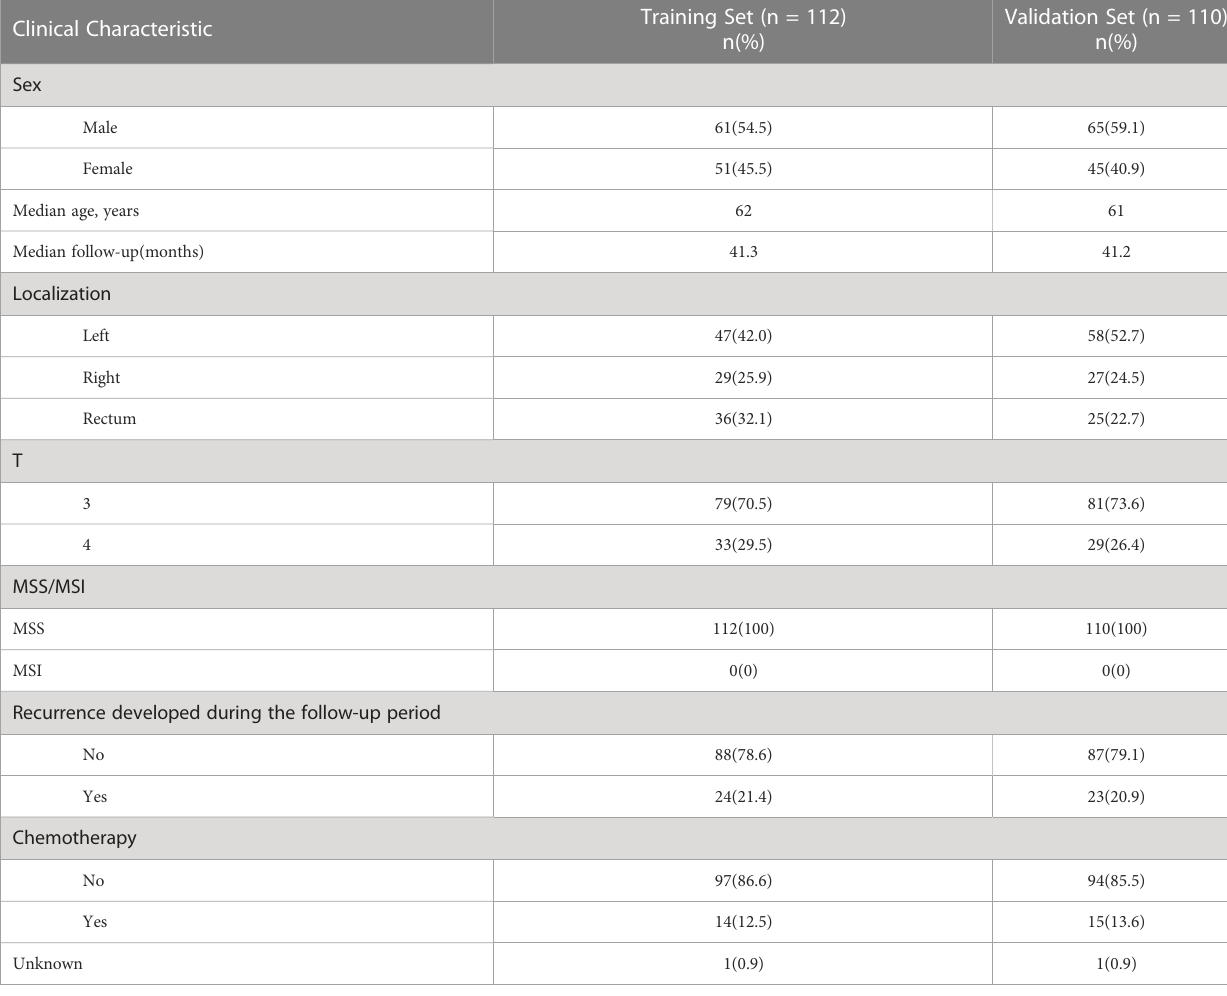
TABLE 1 Main clinicopathological characteristics of formalin- fi xed, paraf fi n-embedded samples of 222 stage II MSS CRC patients.